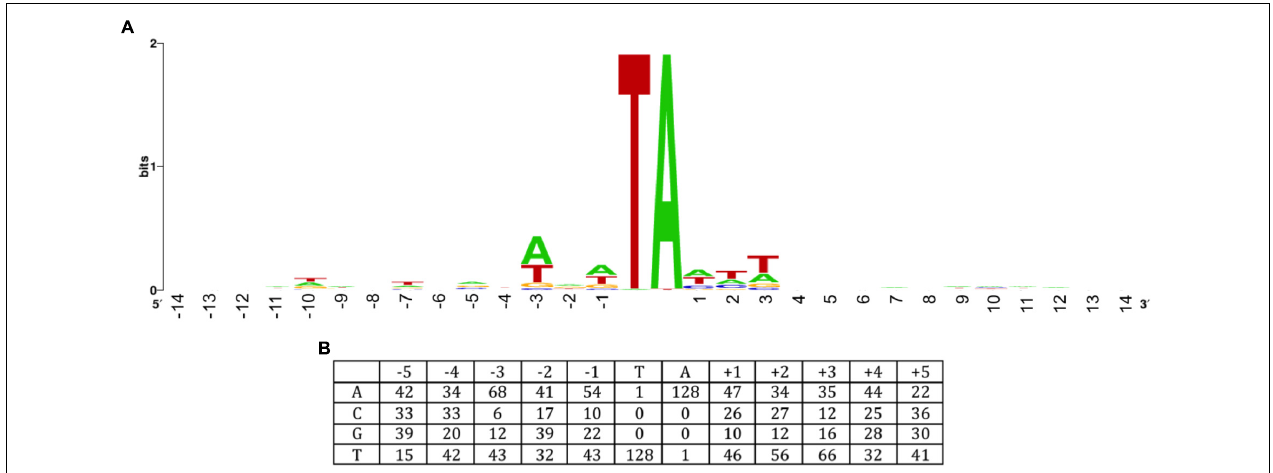
FIGURE 4 | ISY100 target site preference. The sequences of 21 ISY100 insertions in the Synechocystis PCC6803 genome, three in large Synechocystis plasmids, 19 insertions isolated in plasmid targets in E. coli , and 58 different insertion sites generated by in vivo and in vitro transposition into the target plasmid pH2 were previously analyzed (Feng et al., 2010). The 28 insertions isolated in this work were added to this alignment and analyzed for conserved sequence features. (A) WebLogo (Crooks et al., 2004) showing sequence information content 14 nucleotides on either side of the target TA. (B) Base frequencies 5 nucleotides on either side of the target